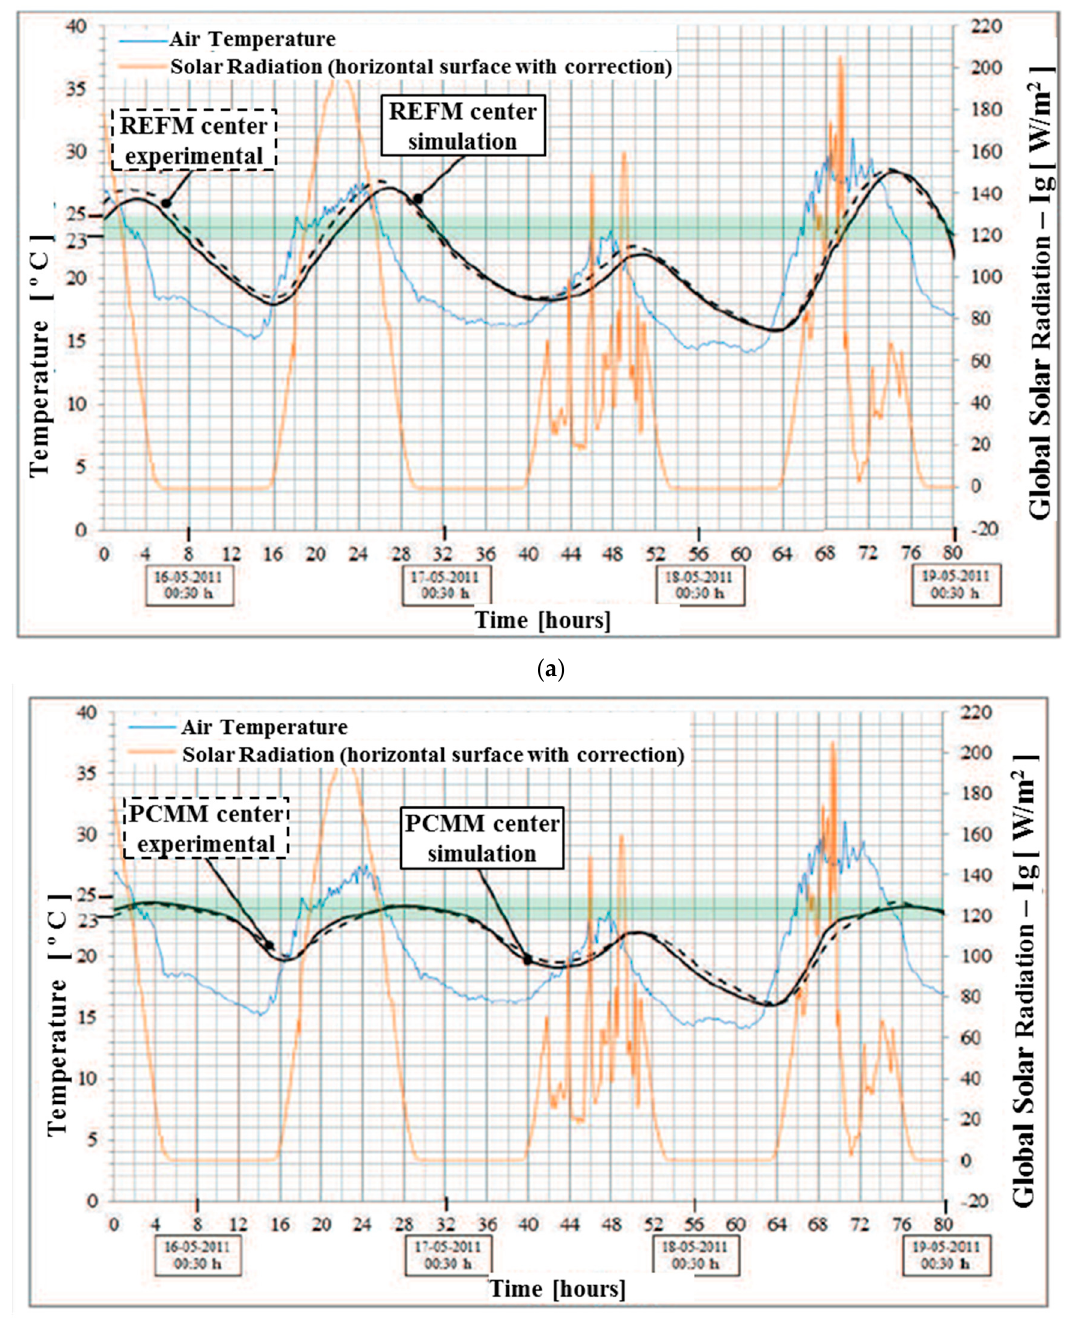
Figure 15. In situ monitoring and numerical simulation of the temperatures in the center of ( a ) PCMM test cell and ( b ) REFM test cell, between 15th and 19th May.